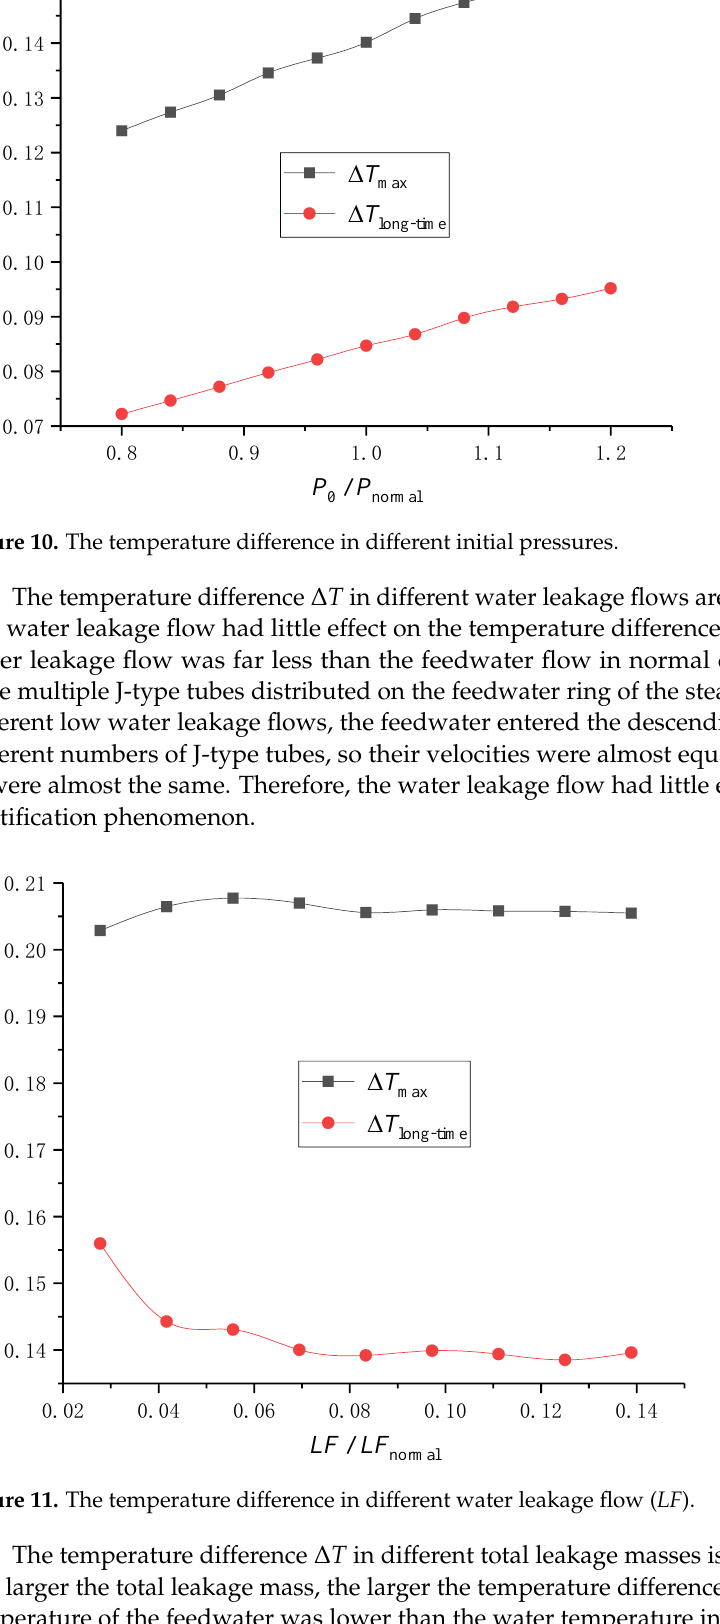
Figure 11. The temperature difference in different water leakage flow ( LF ). The temperature difference ∆ T in different total leakage masses is shown in Figure 12. The larger the total leakage mass, the larger the temperature difference. This is because the temperature of the feedwater was lower than the water temperature in the steam